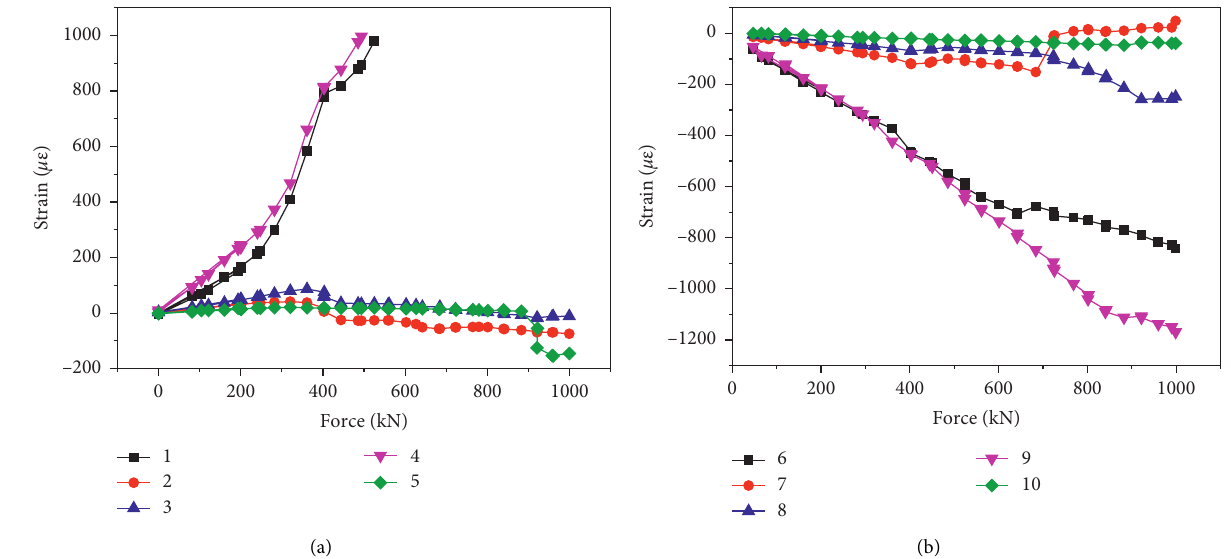
Figure 19: Load-strain curves of concrete fiber of SC-P1. (a) Lower fiber; (b) upper fiber.